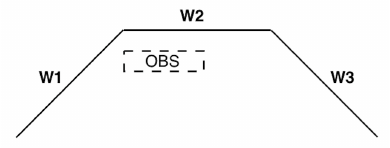
Figure 12. Situation with left and right